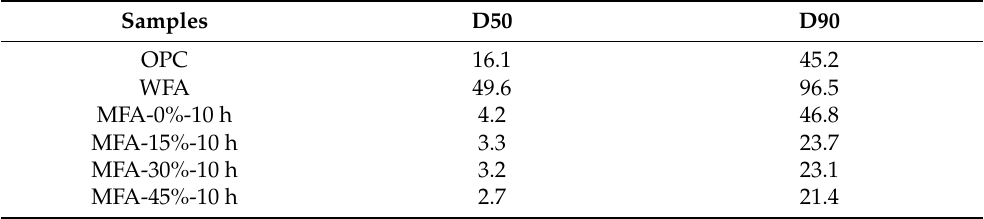
Figure 2. Particle size distribution of the samples under different operating conditions. Table 2. D50 and D90 of the samples under different operating conditions ( µ